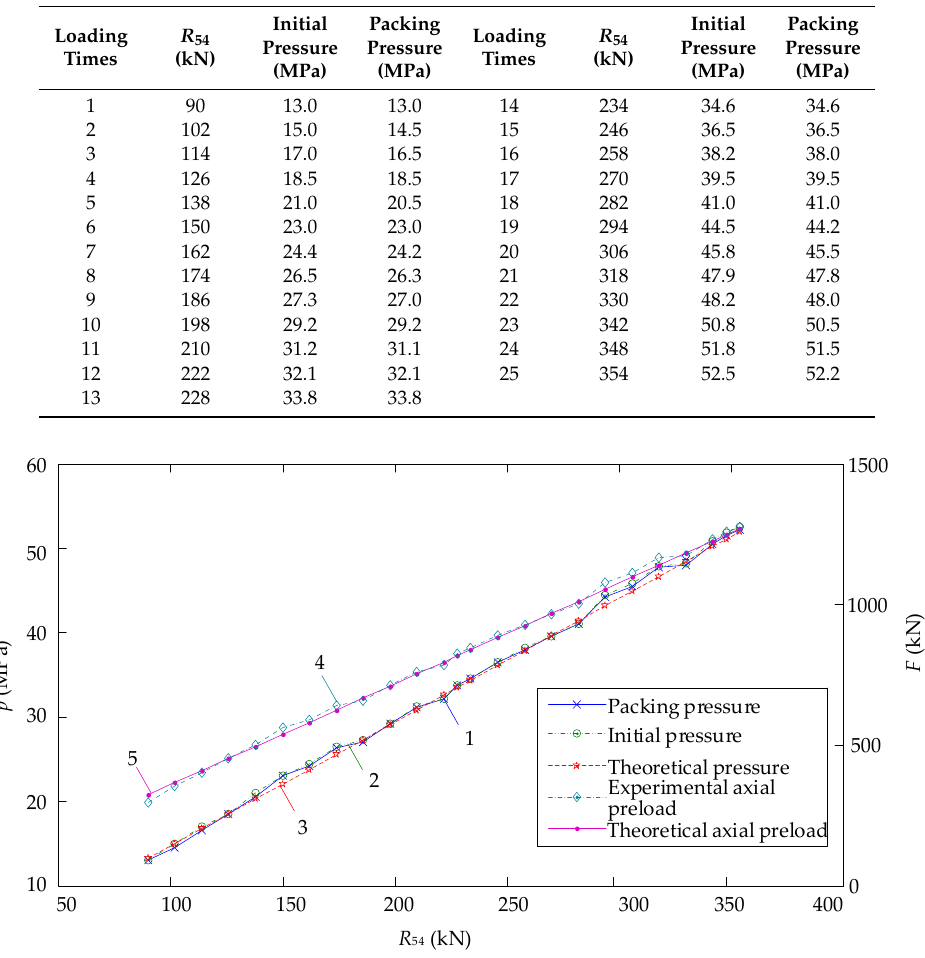
Table 1. Hydrostatic pressure experiment data.